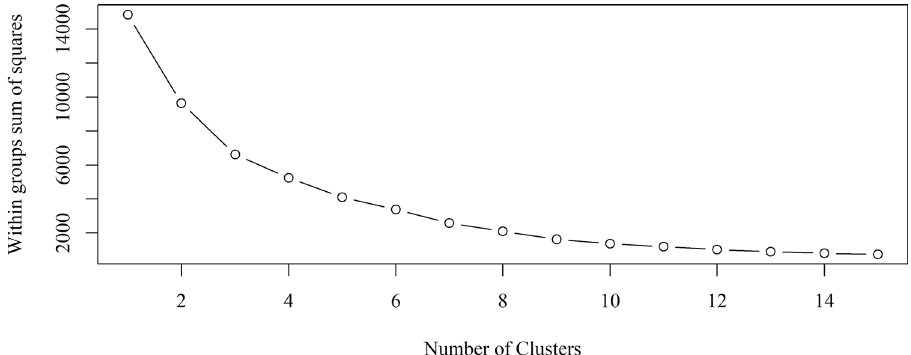
Figure 2. Sum of squares graph plot for different numbers of clusters. The best ‘k’ is chosen at the point where the marginal gain sharply decreases, yielding an angle in the graph (the “elbow” criterion); in our case, the value is six.